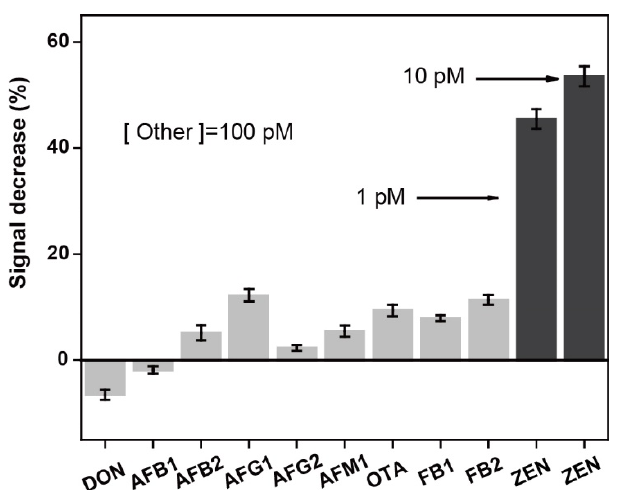
Figure 7. Specificity tests against a panel of common mycotoxins. DON: deoxynivalenol; AFB1: aflatoxin B1; AFB2: aflatoxin B2; AFG1: aflatoxin G1; AFG2: aflatoxin G2; AFM1: aflatoxin M1; OTA: ochratoxin A; FB1: fumonisin B1; and FB2: fumonisin B2. All the measurements were repeated three times and the errors were calculated from the three repeats.